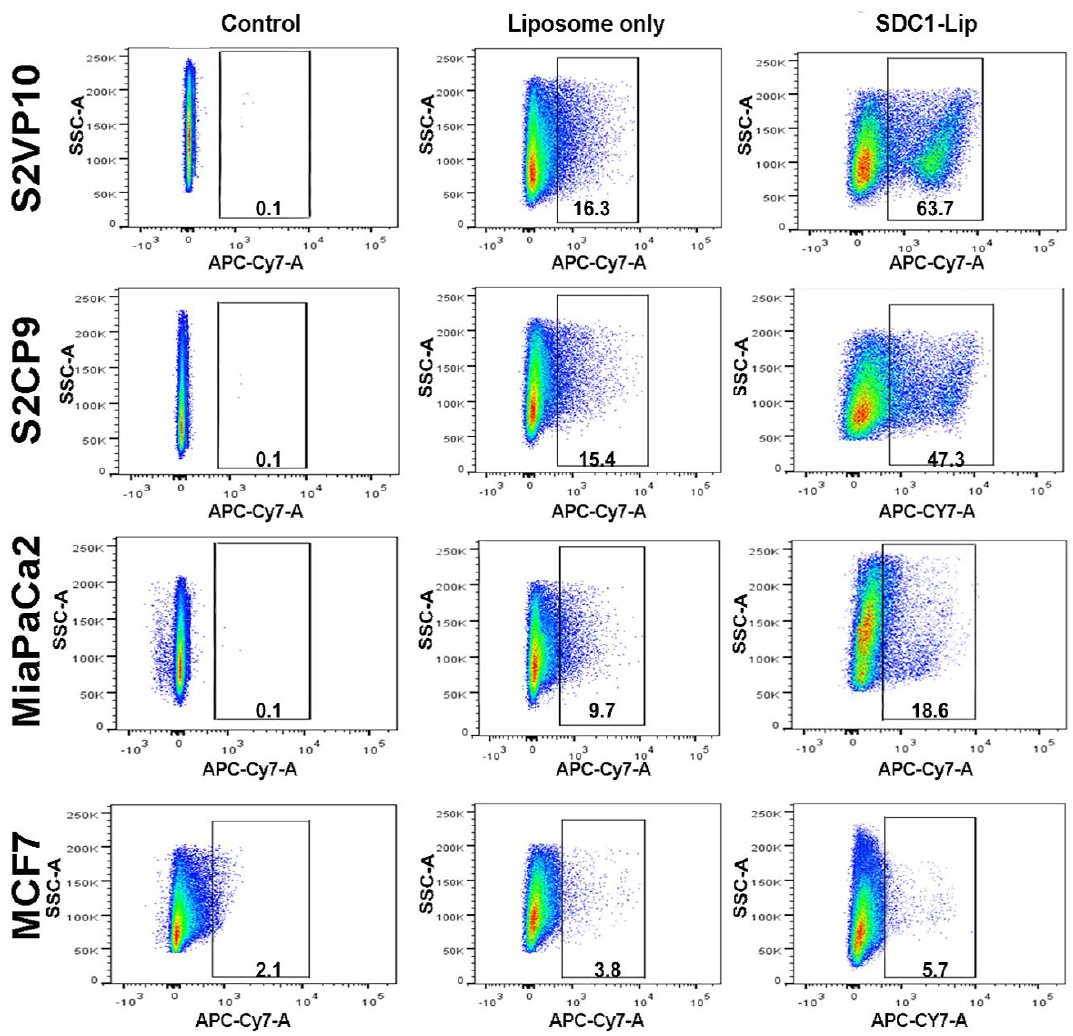
Figure 1. Assessment of syndecan-1 peptide (SDC1-Lip) uptake in cells using flow cytometry. S2VP10, S2CP9, and Miapaca2 cells treated with SDC1-Lip compared to untargeted liposome IR780; control S2VP10 = 63.7% ( p = 0.00002), S2CP9 = 47.3% ( p = 0.00021), and Miapaca2 = 18.6% ( p = 0.01994). MCF-7 (negative control) cells treated with SDC1-Lip IR780 had 5.7% uptake ( p = 0.37331).